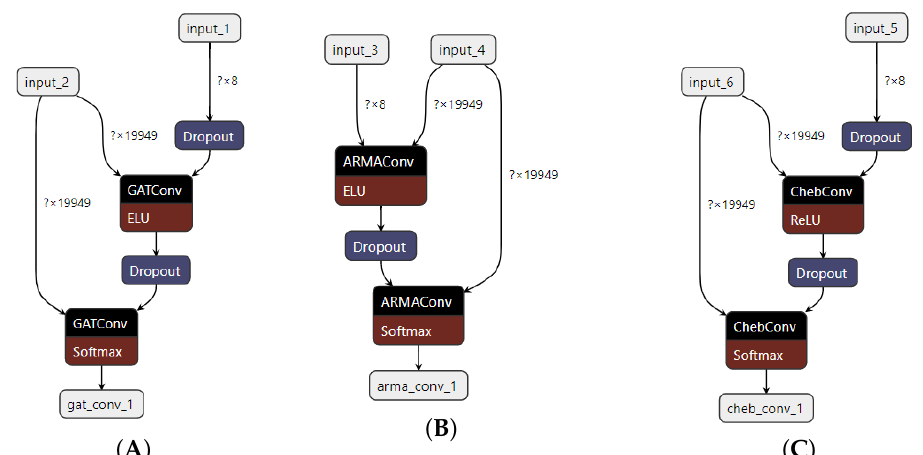
Figure 1. Structures of examined graph neural networks: ( A ) GAT, ( B ) ARMA, and ( C ) Chebyshev.